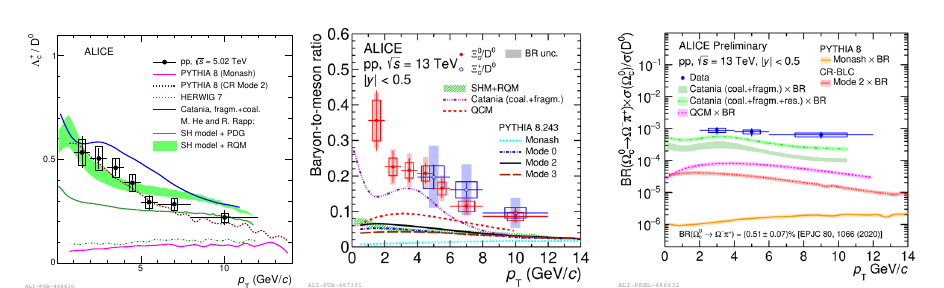
Figure 1. Left: The Λ + c / D 0 ratio as a function of p T measured in pp collisions at √ s = 5 . 02 TeV / D 0 and Ξ + / D 0 ratios measured in pp collisions at √ s = 13 TeV [8]. Right: The [7]. Middle: The Ξ 0 c c / D 0 measured in pp collisions at √ s = 13 TeV. All the charm baryon-to-meson yield ratios are Ω 0 BR c × compared to theoretical calculations [2–5,